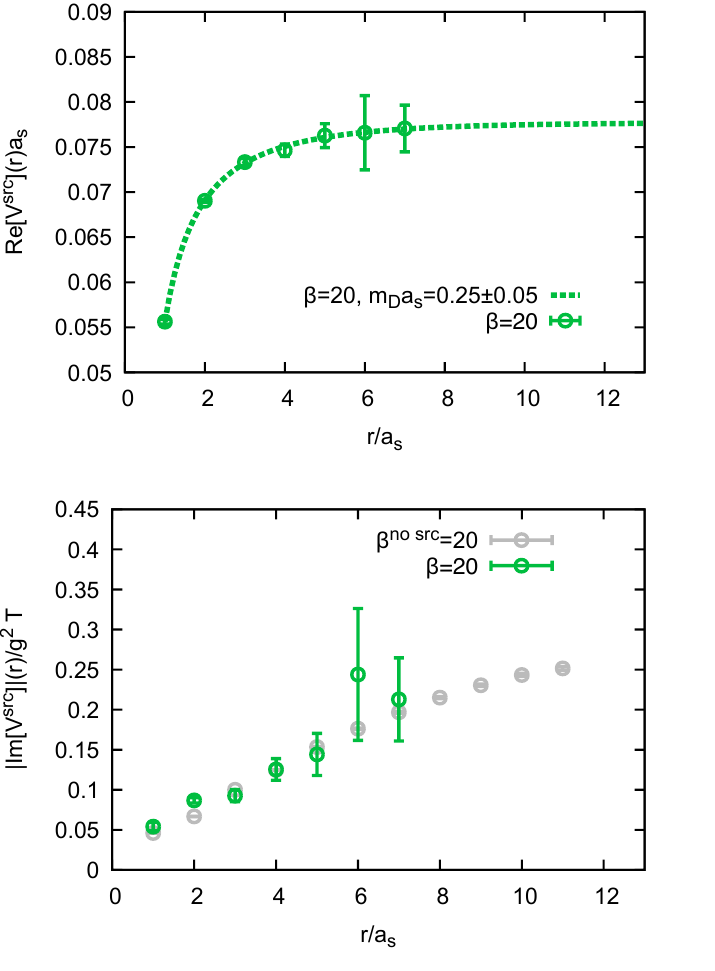
Figure 7 . Real- (top) and imaginary (bottom) part of the static quark potential evaluated in the presence of sources at β = 20 on N x = 32 lattices. As expected from the behavior of the real-time Wilson loop we now find both a finite real- and imaginary part. The former exhibits clear signs of screening as indicated by the Debye fit (dashed gray line). The latter shows the expected monotonous increase with spatial distance. Results in the absence of sources are shown as gray symbols and reveal a very good agreement of Im[ V ] between the simulations with and without back